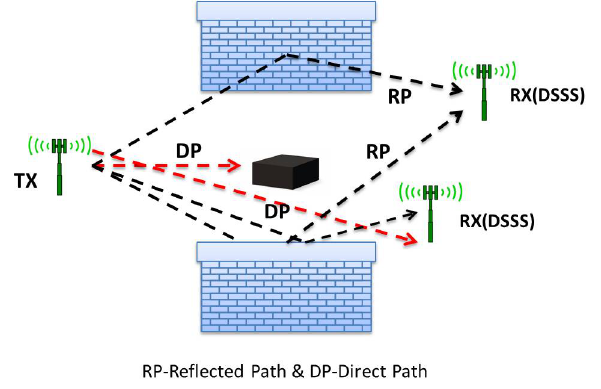
Figure 6. DLoS and DSSS scenarios for ToF